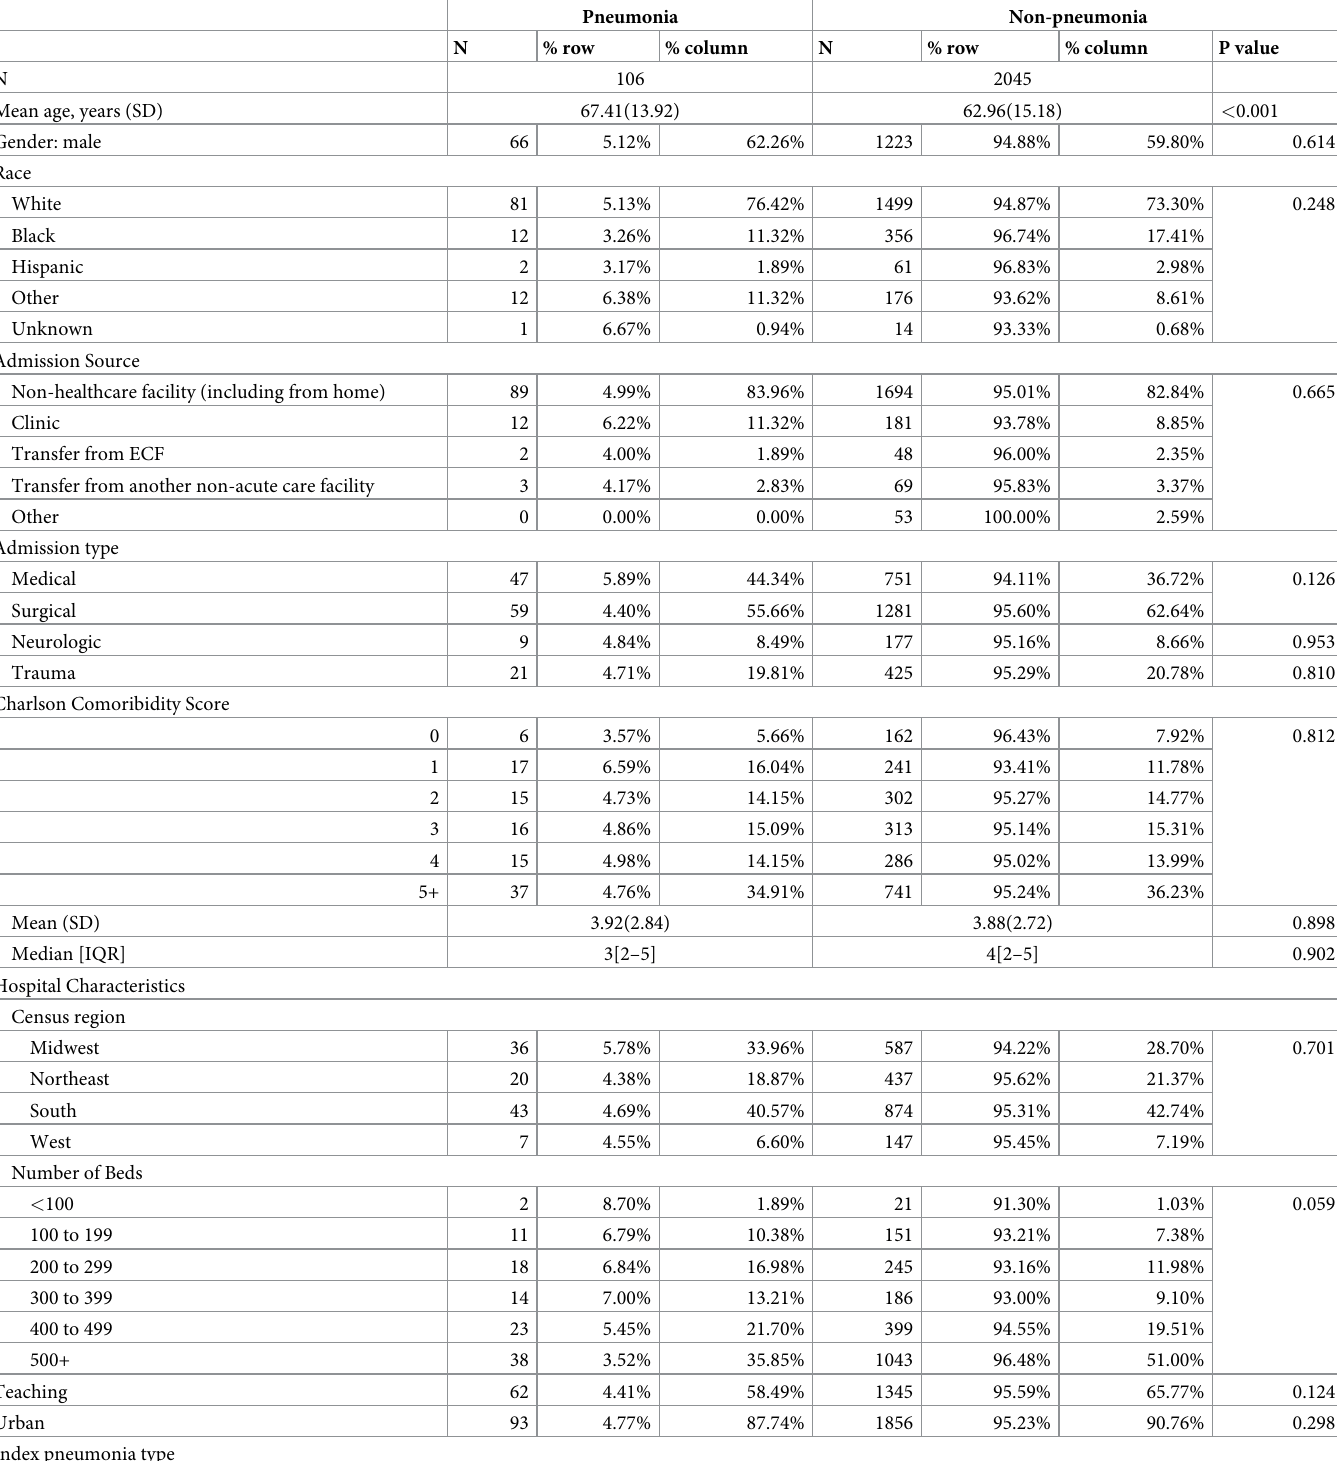
Table 1. Baseline characteristics at index hospitalization among patient readmitted within 30 days of